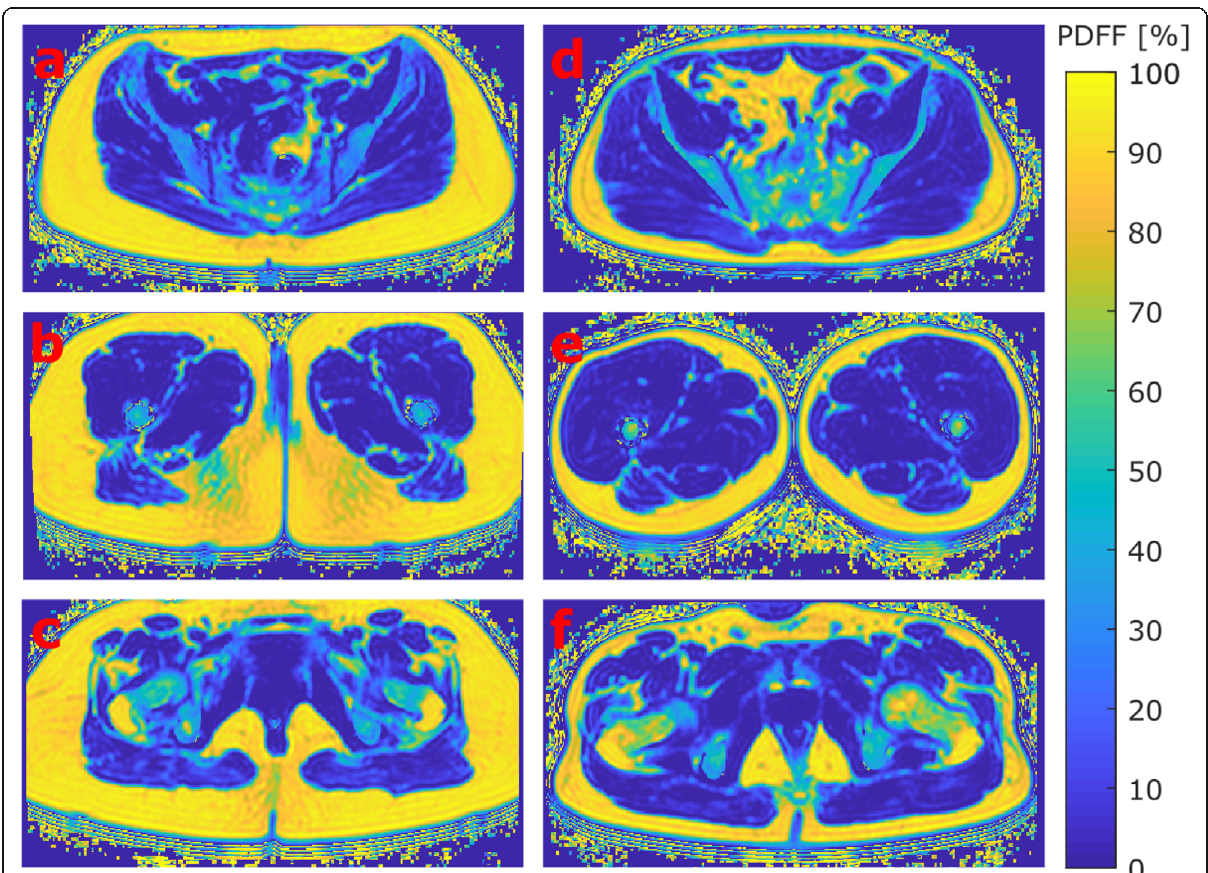
Fig. 3 Representative colour-coded axial PDFF maps of the gluteal ( a , d ), quadriceps ( b , e ), and femoral neck ( c , f ) regions of a 39-year-old female subject (BMI 25.7 kg/m 2 , left column a – c ) and a 41-year-old male subject (BMI 25.8 kg/m 2 , right column d – f ), respectively. BMI , Body mass index; PDFF , Proton density fat